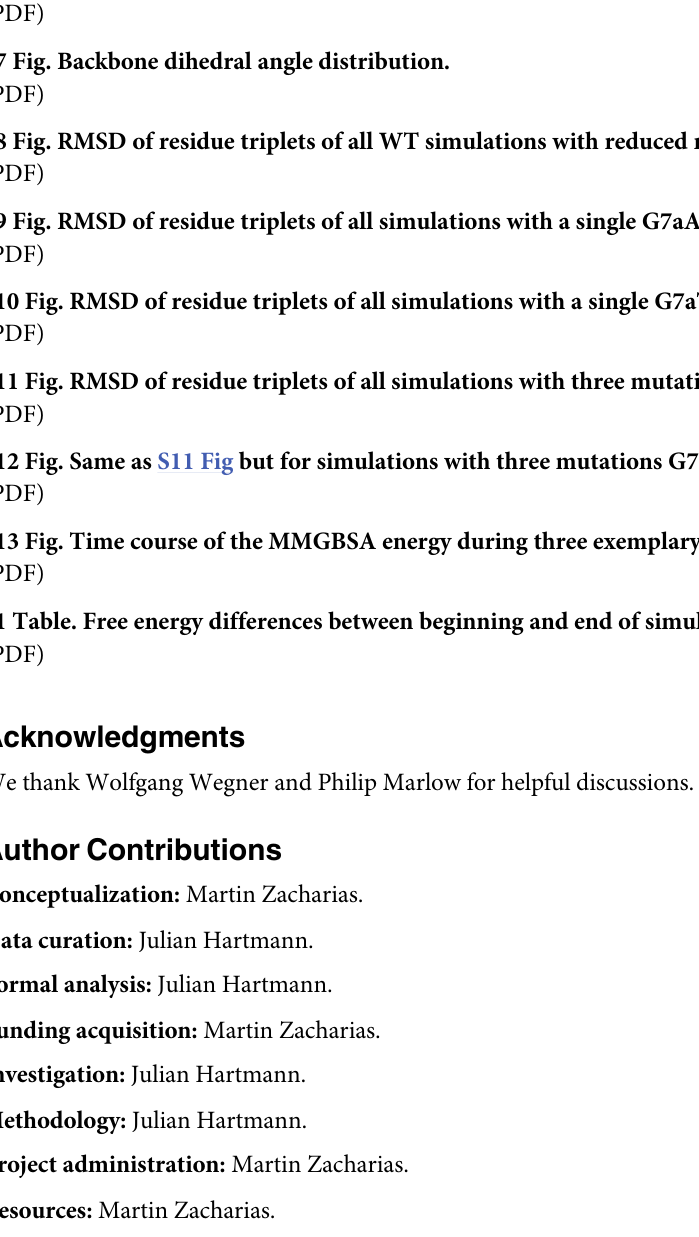
S2 Fig. Root Mean Square Fluctuations of an unrestrained vs. restrained triple helix. (PDF) S3 Fig. Root Mean Square Deviation (RMSD) of individual chains vs. simulation time. (PDF) S4 Fig. RMSD of residue triplets of all wild type simulations. (PDF) S5 Fig. Detailed example of a folding process at one point along the triple helix. (PDF) S6 Fig. RMSD of individual chains during triple helix folding. (PDF) S7 Fig. Backbone dihedral angle distribution. (PDF) S8 Fig. RMSD of residue triplets of all WT simulations with reduced restraints. (PDF) S9 Fig. RMSD of residue triplets of all simulations with a single G7aA mutation. (PDF) S10 Fig. RMSD of residue triplets of all simulations with a single G7aT mutation. (PDF) S11 Fig. RMSD of residue triplets of all simulations with three mutations G7abcA. (PDF) S12 Fig. Same as S11 Fig but for simulations with three mutations G7abcT. (PDF) S13 Fig. Time course of the MMGBSA energy during three exemplary simulations. (PDF) S1 Table. Free energy differences between beginning and end of simulations.